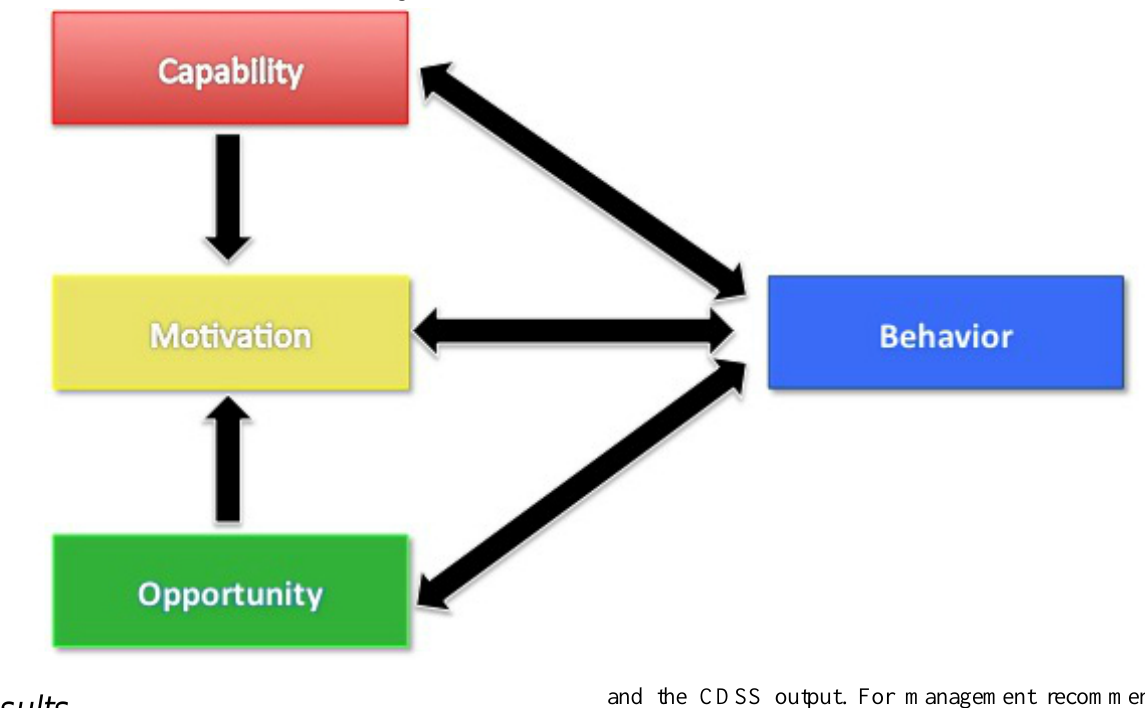
Figure 2. The COM-B framework for understanding